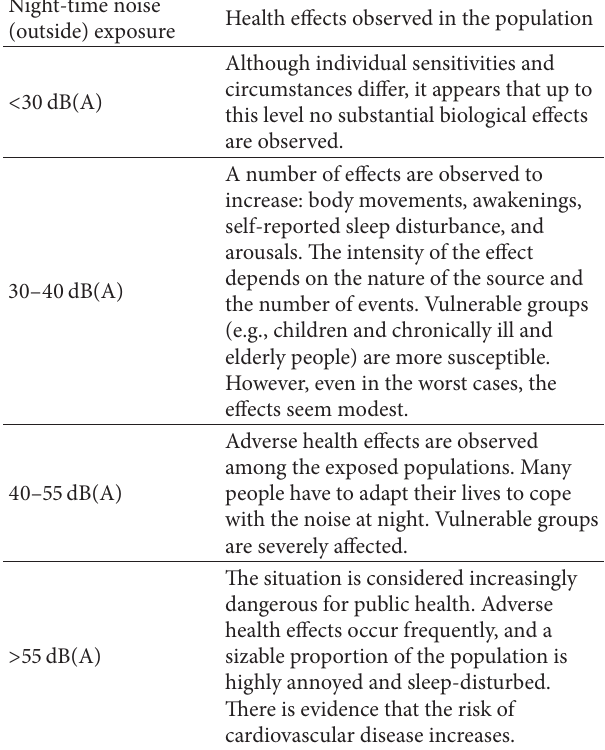
Table 1: Range for the relationship between nocturnal noise expo- sure and health effects in the